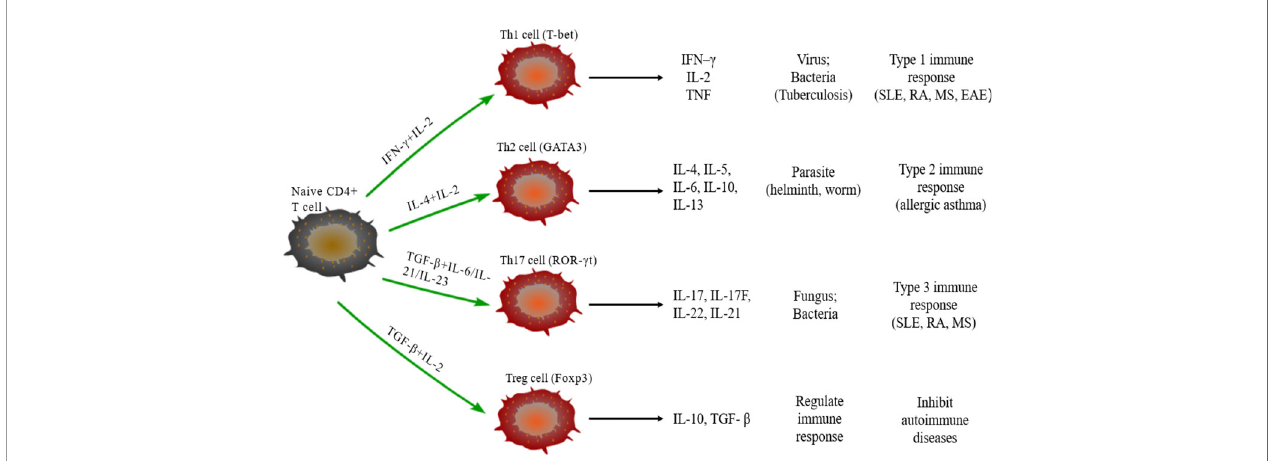
FIGURE 1 | Differentiation of naïve CD4 + T cells. Naive CD4 + T cells can differentiate into Th1 cells under the stimulus of IFN- g and IL-2, secrete IFN- g , IL-2, and TNF, and participate in type 1 immune response. Under the stimulus of IL-2 and IL-4, naive CD4 + T cells differentiate into Th2 cells that can secrete IL-4/5/6/10/13 and participate in type 2 immune response. The differentiation of Th17 cells need TGF- b , IL-6, IL-21, and IL-23, and participate in type 3 immune response through secreting IL-17/17F/21/22; TGF- b and IL-2 are required for naïve CD4 + T cells to differentiate into Treg cells that secrete IL-10 and TGF- b regulate the immune